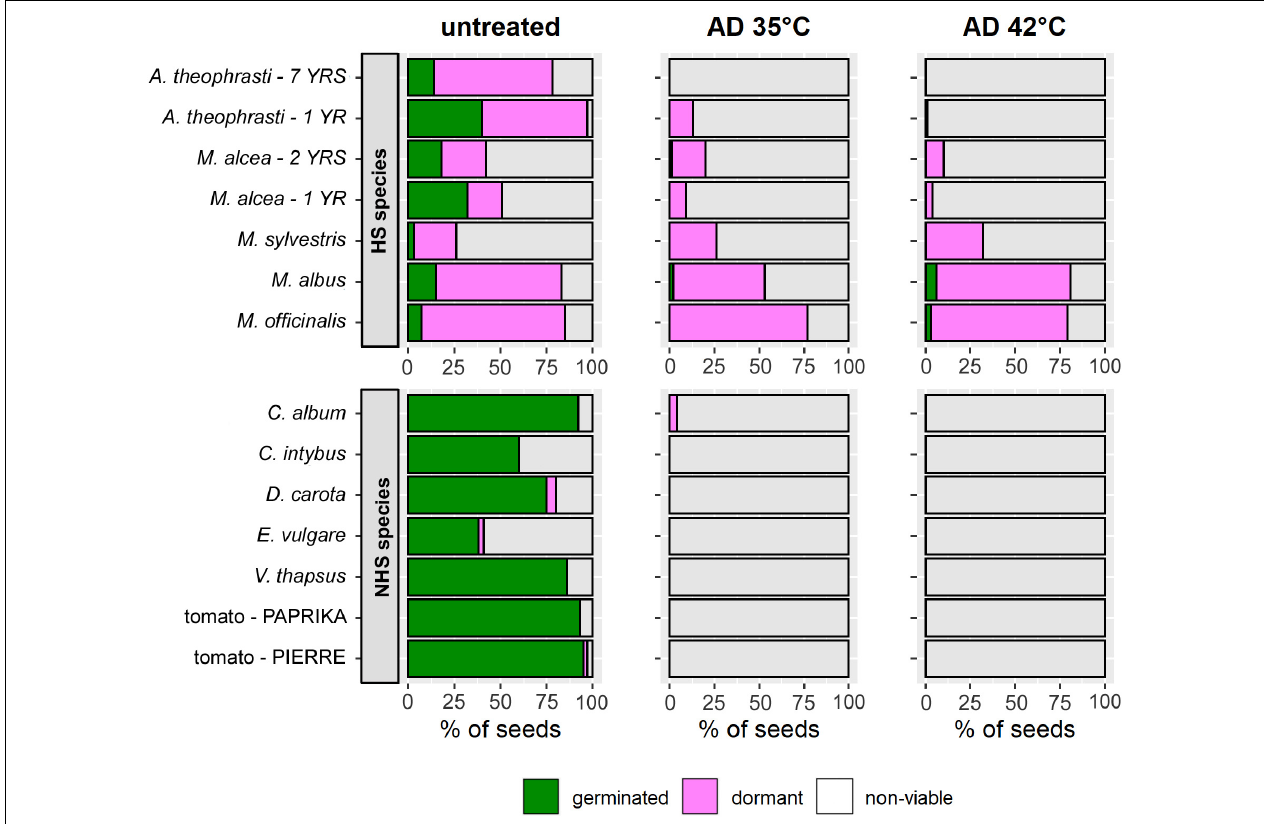
FIGURE 3 | Mean percentages of germinated (green), dormant (pink), and non-viable seeds (gray) in batches of flowering wild plant species and tomato that were either untreated (left) or exposed to AD at 35 ◦ C (center) or 42 ◦ C (right) for 36 days. The top row shows the values for species with hardseededness (HS), the bottom row those for non-hardseeded (NHS) species. The percentage of germinated seeds equals the cumulative germination ( cG ) after completion of the 21-day germination test after AD-treatment. Values were predicted from models for V(t) and cG(t) .